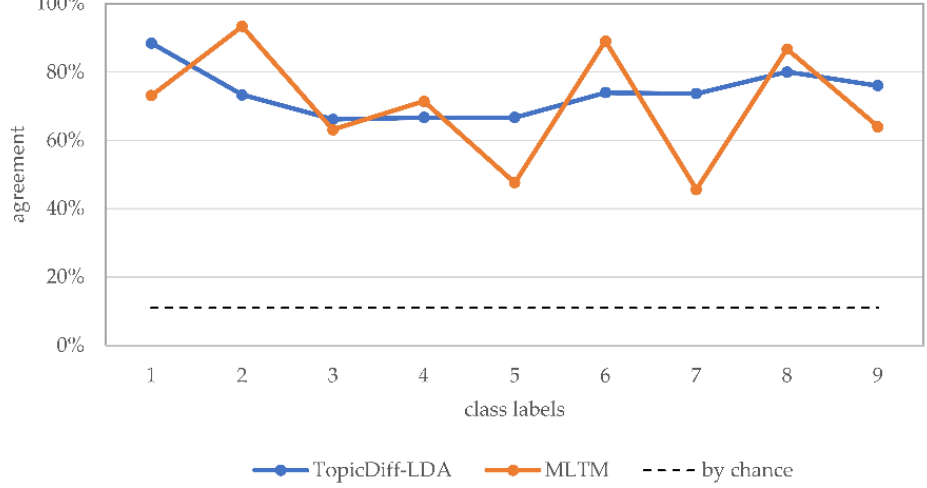
Figure 4. Agreement for sets labeled with TopicDiff-LDA and MLTM relative to human annotation.